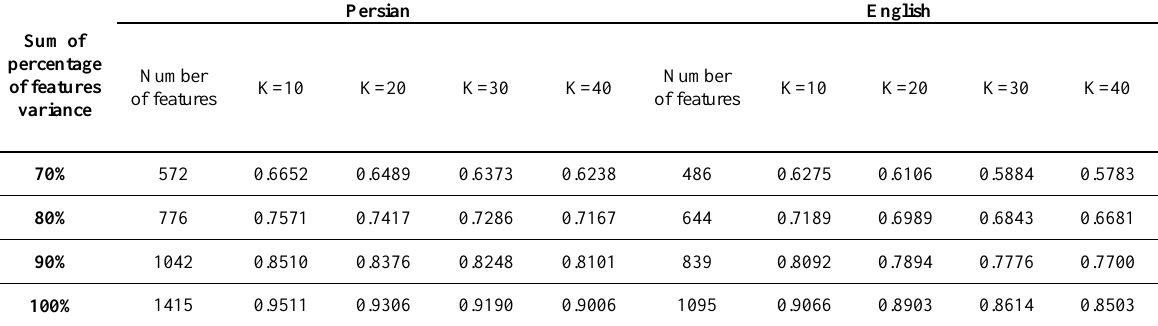
Table 2. Comparing Persian and English clusters with equal amount of information loss for several Ks. Sum of percentage of features